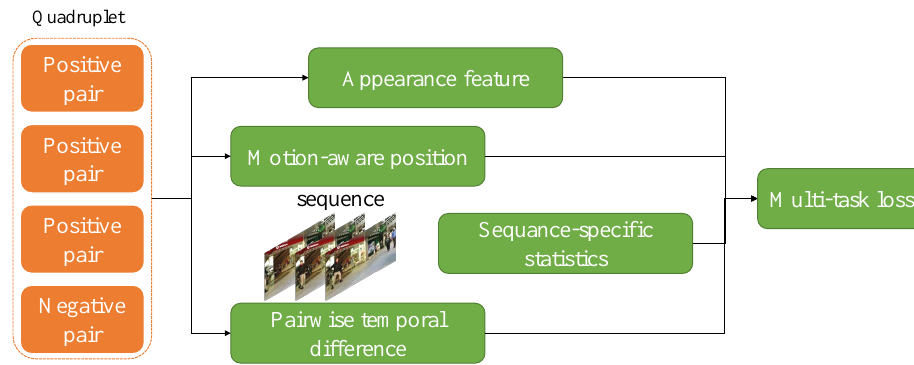
Figure 16. The automatic detection learning model proposed by Son et al. [85] using the MOT15 benchmark [8].